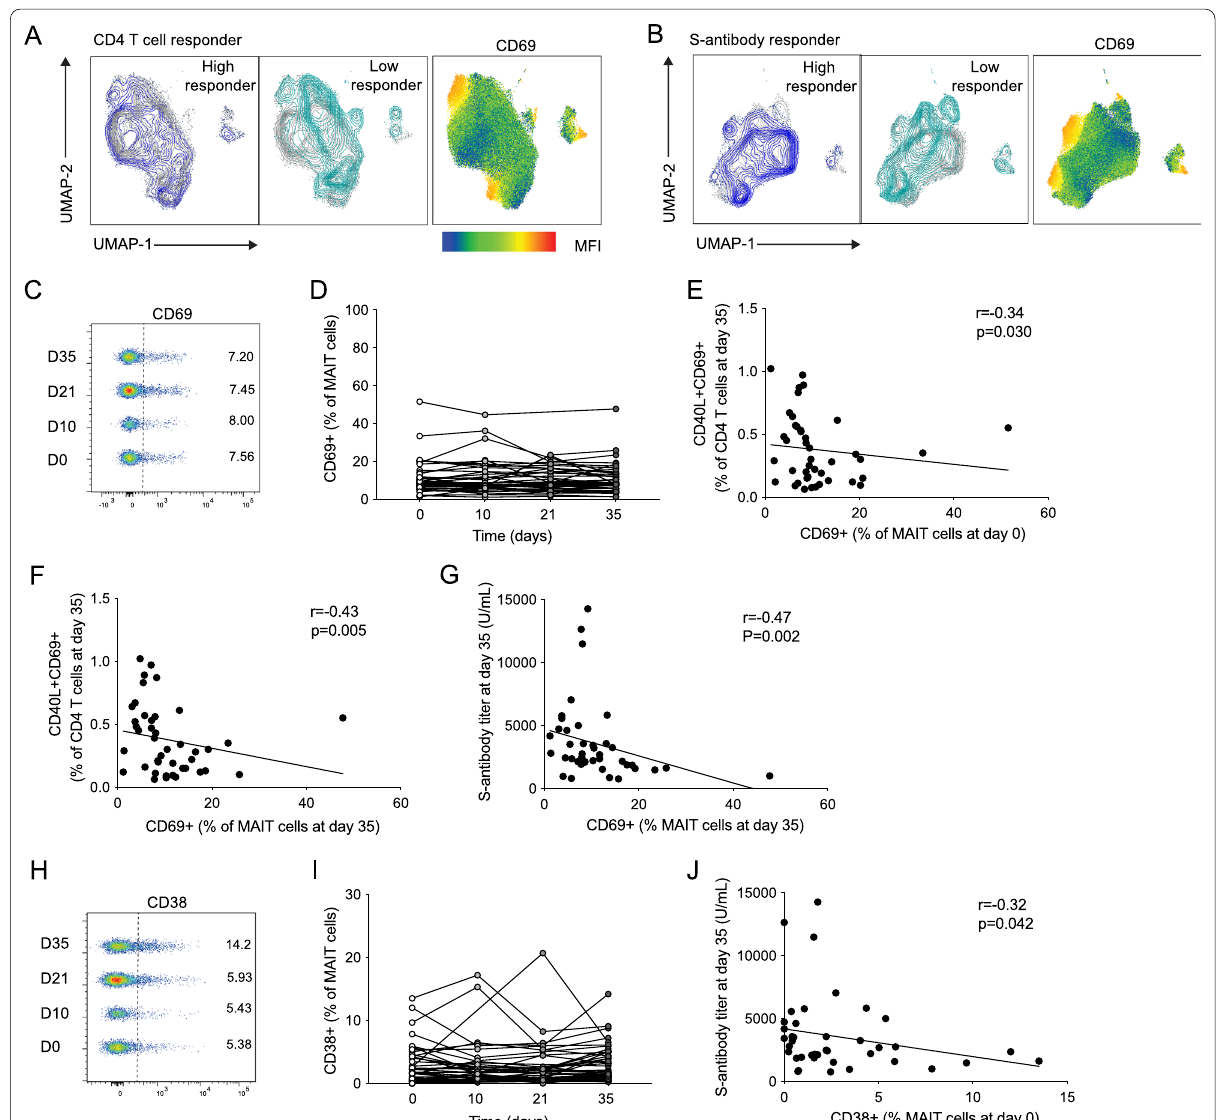
Fig. 2 Negative association between MAIT cell activation markers and vaccine responses. Uniform Manifold Approximation and Projection (UMAP) plots of the total MAIT cell pool with overlay color indicating data from high or low spike‑specific CD4 T cell responses ( A , left) or S‑antibody titer ( B , left) and showing MAIT cell expression of the activation marker CD69 ( A , right; B , right). Concatenated flow cytometry plots ( C ) and combined data ( D ) of MAIT cell CD69 expression (n 36–42) at the different time points in the healthy donor group. Correlation of the percentage of = CD40L CD69 CD4 T cells at day 35 (n 42) with the percentage of CD69 MAIT cells at day 0 (n 42) ( E ) or day 35 (n 42) ( F ). G Correlation + + = + = = between the S‑antibody titer at day 35 (n 41) and expression of CD69 on MAIT cells at day 35 (n 42). Concatenated flow cytometry plot ( H ) = = and combined data ( I ) of MAIT cell CD38 expression (n 36–42) at the different time points in the healthy donor group. J Correlation between the = S‑antibody titer at day 35 (n 42) and the CD38 expression on MAIT cells at day 0 (n 42). Associations were assessed using the Spearman rank = = correlation in E – G and